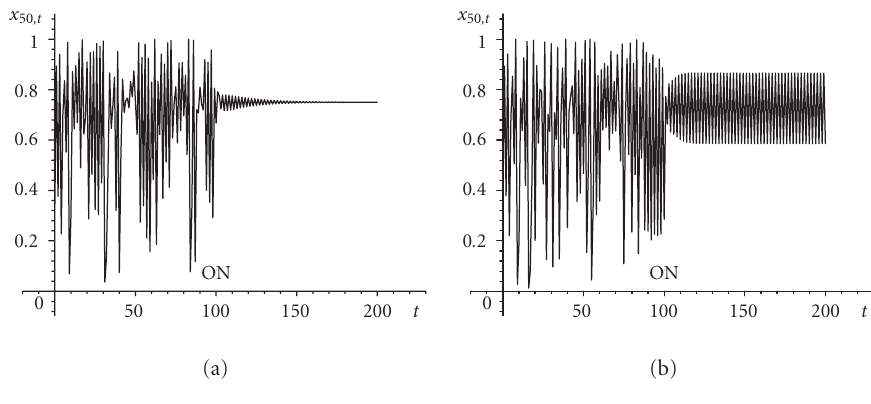
Figure 6.2. Simulations for a coupled map lattice system at critical coupling value (cid:1) ∗ : (a) (cid:1) = 3 / 4, γ = 0 . 35, (b) (cid:1) = 3 / 4, γ = 0 . 15. The adaptive adjustment is trigged at 101th step. Initial states are given randomly around 0 .